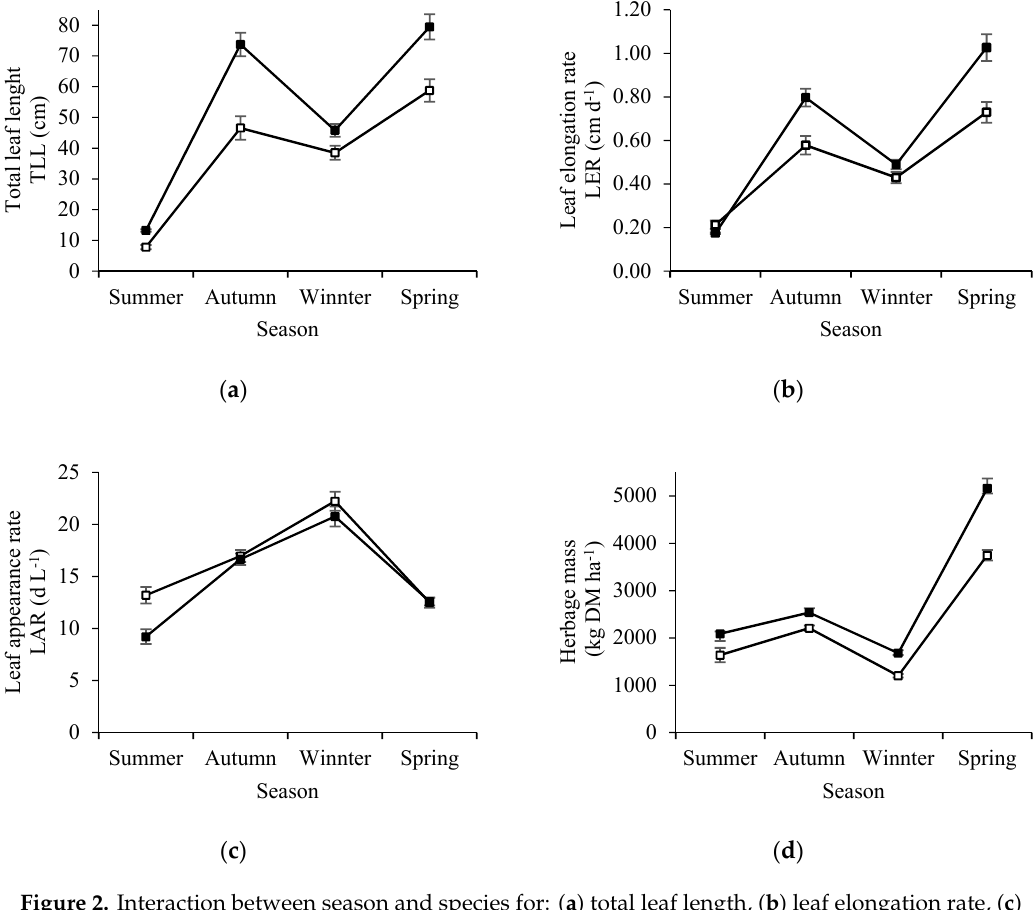
Figure 2. Interaction between season and species for: ( a ) total leaf length, ( b ) leaf elongation rate, ( c ) leaf appearance rate and ( d ) herbage mass in Lolium perenne L. ( □ ) and Bromus valdivianus Phil. ( ■ ).